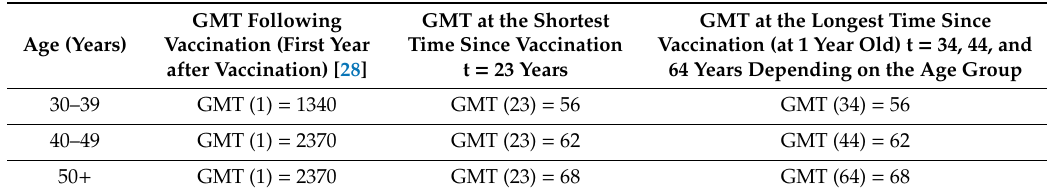
Table 2. Age-specific GMT levels at different estimated times since vaccination.